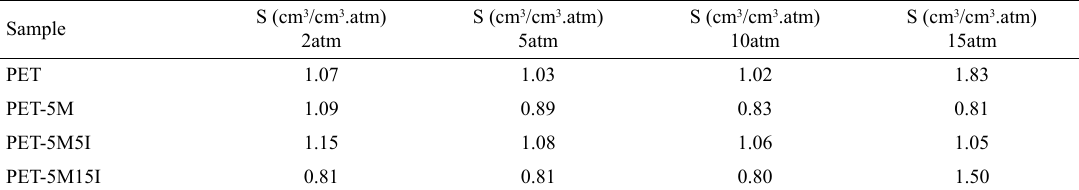
solubility coefficient (S) values for the neat PET and PET nanocomposites with 5 wt% of the organoclay at 35ºC. Table 2. CO 2 Sample